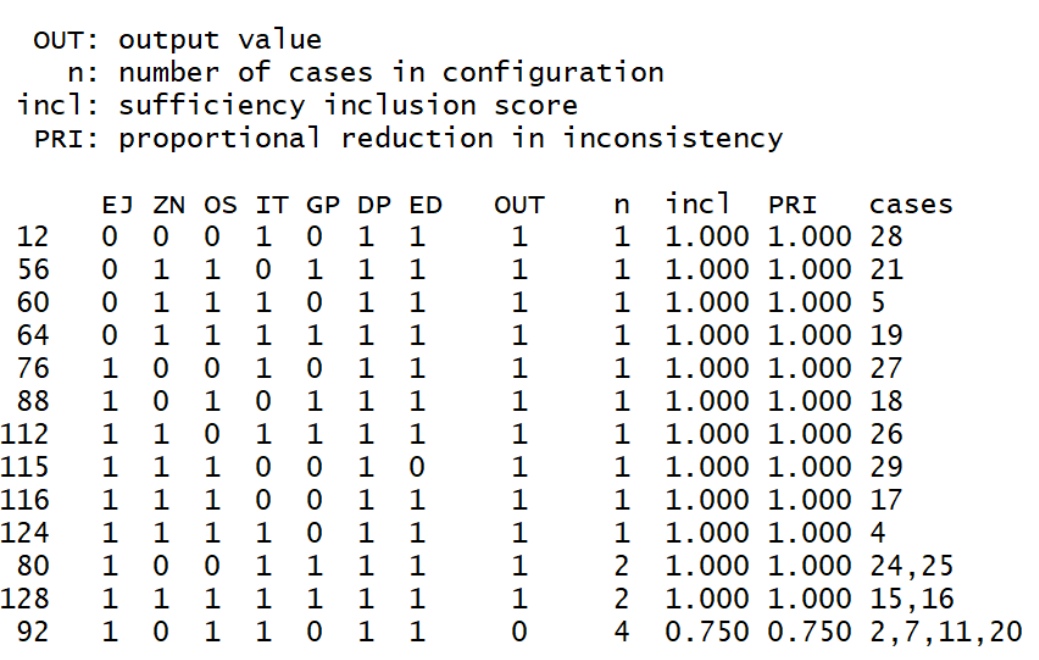
Figure 3. Fragment of the truth table.